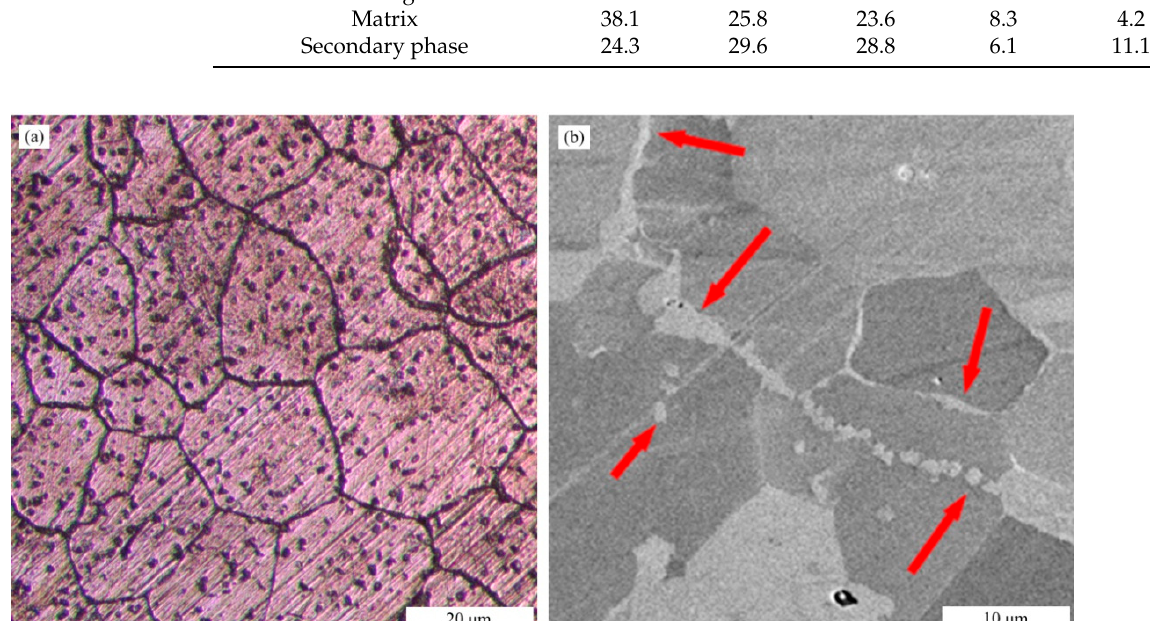
Figure 2. Microstructure of the forged Al 10 Cr 30 Fe 25 Mn 30 Ti 5 HEA at 1200 °C. ( a ) Optical micrograph showing a general view of the microstructure, and ( b ) SEM image, in which can be distinguished small secondary phases, particles (labeled by red arrows) along the grain boundaries of BCC grains.